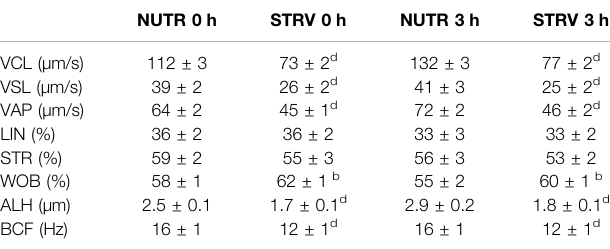
TABLE 1 | Kinematic characteristics of human sperm evaluated after swim-up (0 h) and incubated for 3 h in medium with or without nutrients (NUTR and STRV,respectively).Resultsareexpressedasmean ± SEM, n (cid:1) 18experiments,8 donors ( ≤ 3 samples per donor). b p < 0.01, d p < 0.0001 vs. NUTR. Two-way ANOVA, and Bonferroni ’ s multiple comparison